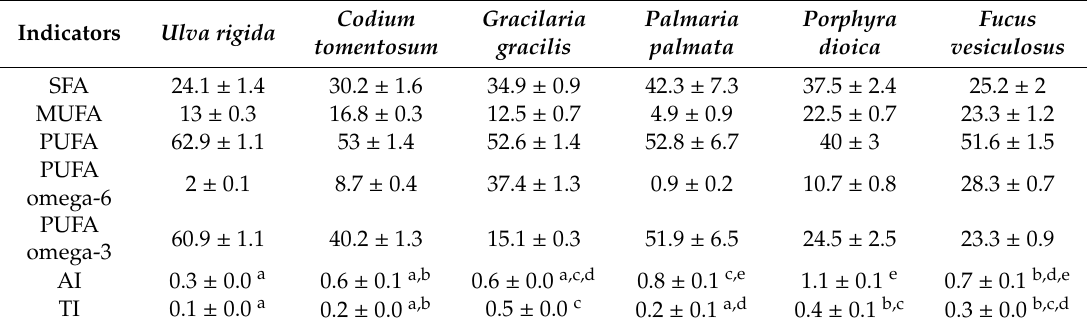
Table 2. Fatty acids indicators of green Ulva rigida and Codium tomentosum ; red Gracilaria gracilis , Palmaria palmata and Porphyra dioica ; and brown Fucus vesiculosus macroalgae. Values correspond to relative abundances (except for AI and TI calculation) and are presented as average of five